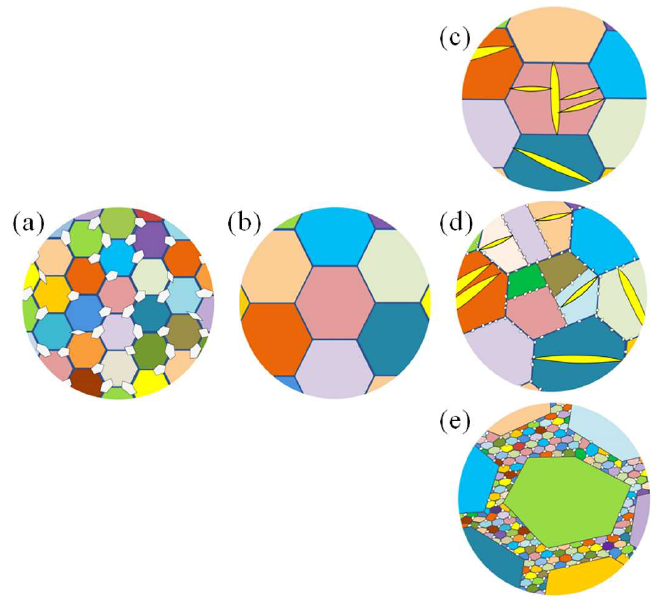
Figure 5. Schematic diagram of the microstructure evolution of AZ91 alloys processed by ECAP and SPR with varied rolling reductions: ( a ) HE, ( b ) heated HE alloy, ( c ) HER-20%, ( d ) HER-40%, ( e ) HER-60% & 70%.